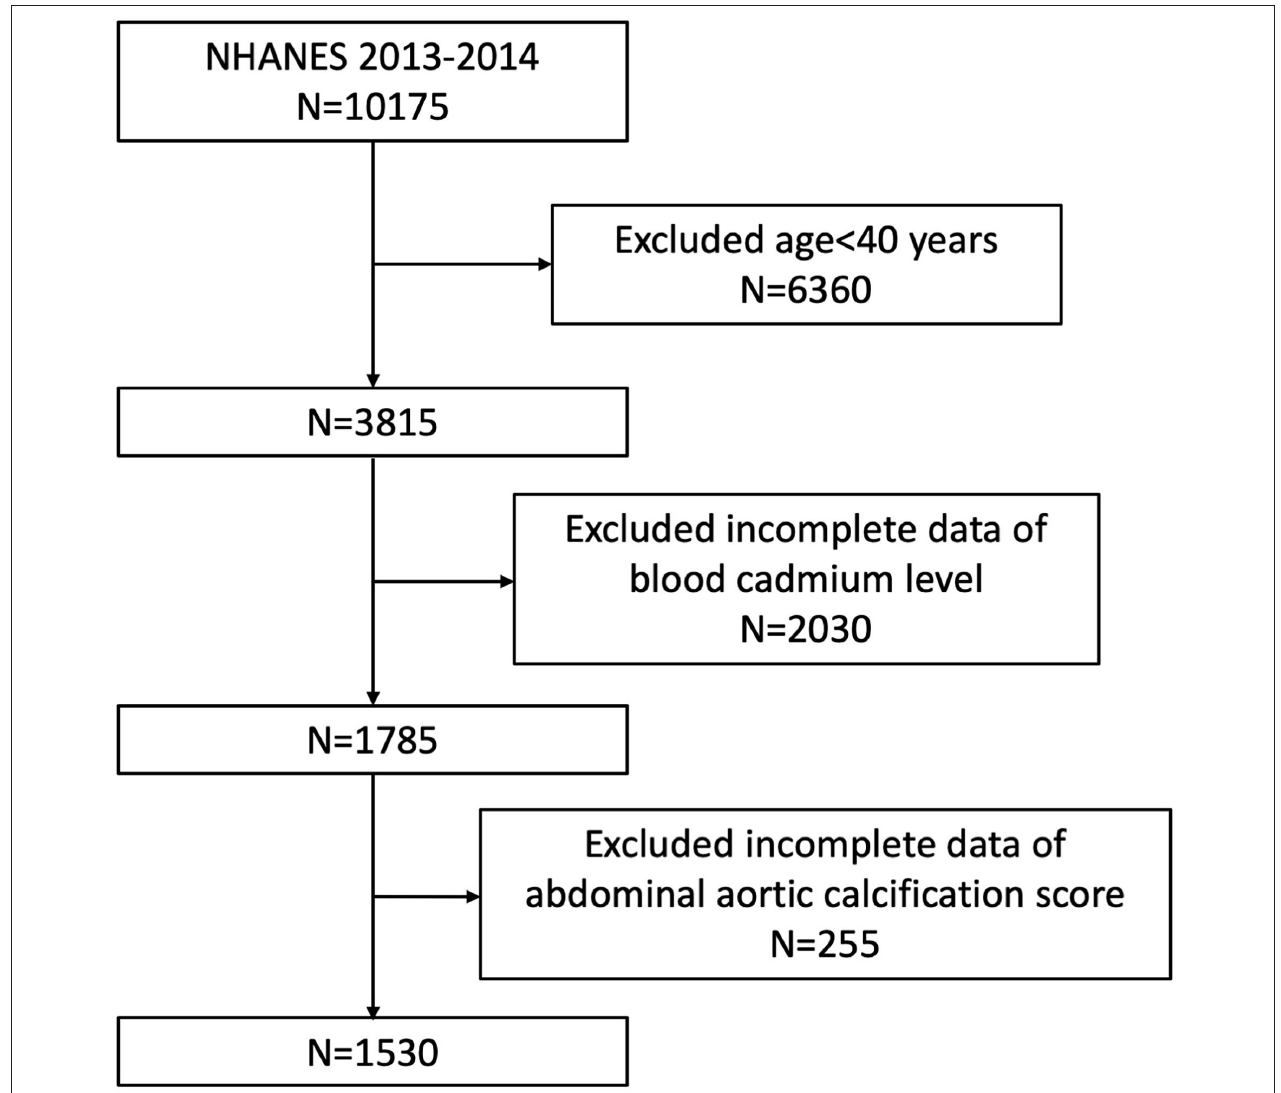
FIGURE 1 | Flowchart of the sample selection from the 2013–2014 National Health and Nutrition Examination Survey